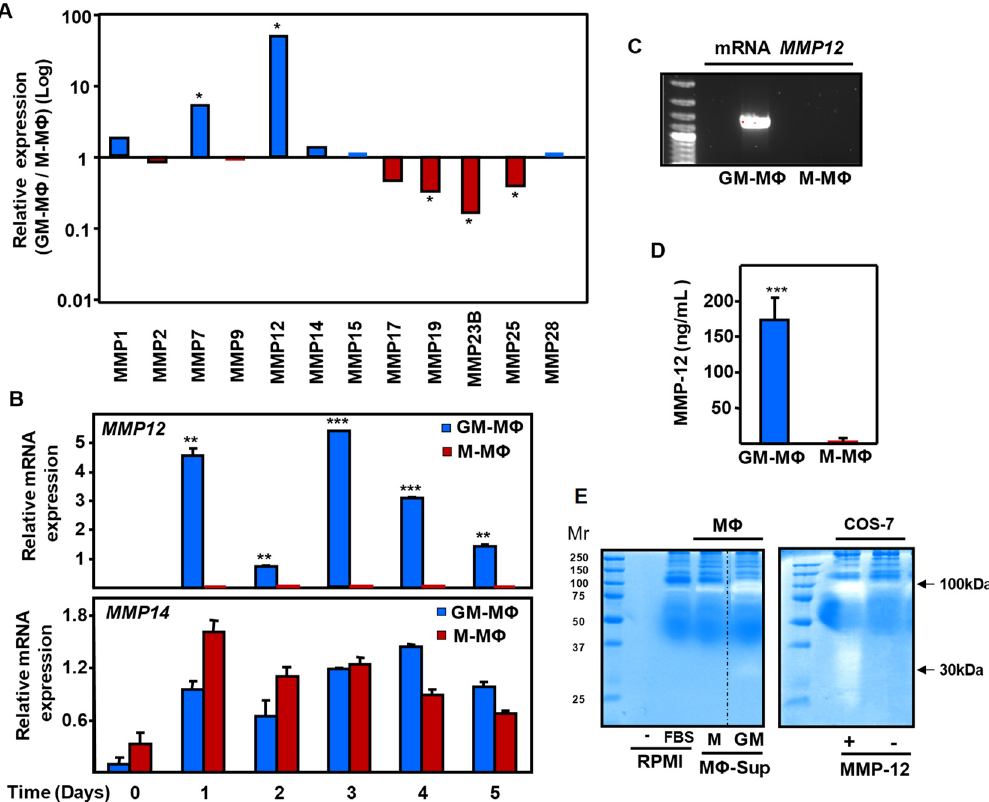
Figure 2. Expression profile of matrix metalloproteinases (MMPs) in GM-M Φ and M-M Φ . Human monocytes were incubated with GM-CSF or M-CSF, resulting in GM-M Φ and M-M Φ , respectively. ( A ) The relative mRNA expression levels of di ff erent MMPs was determined by qRT-PCR and represented by the GM-M Φ / M-M Φ ratio. ( B ) mRNA expression levels of MMP-12 and MMP-14 along GM-M Φ and M-M Φ polarization, as determined by qRT-PCR. The statistical significance of GM-M Φ versus M-M Φ data is shown. ( C ) MMP-12 mRNA expression of GM-M Φ and M-M Φ analyzed by RT-PCR, followed by agarose gel analysis of the product. ( D ) MMP-12 protein levels in culture supernatants at the final stage of di ff erentiation were measured by ELISA. ( E ) Caseinolytic zymography assay of culture supernatants of GM-M Φ and M-M Φ (left panel), and COS-7 cells transfected with or without an expression vector encoding MMP-12 (right panel). A control of RMPI medium with or without fetal bovine serum (FBS) was included in the left panel. The caseinolytic activity was revealed by the white staining over the blue background of total proteins stained with Coomassie Brilliant Blue. Statistical analysis of triplicates was calculated using the paired two-tailed Student t test and data are presented as mean ± SD. (* p < 0.05; ** p < 0.01; *** p <